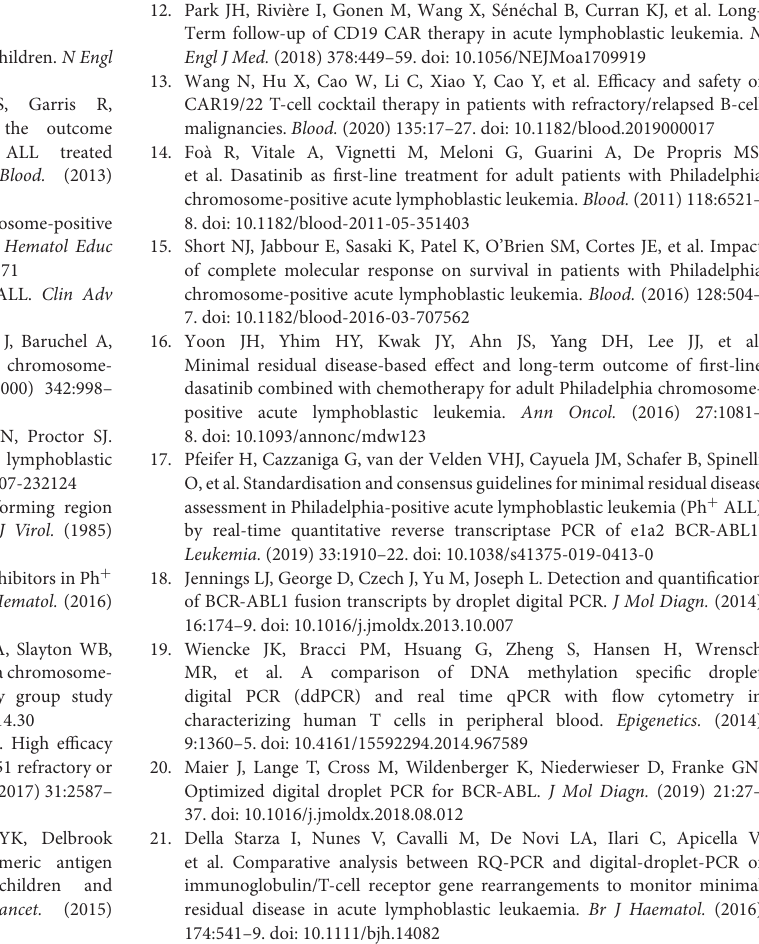
Supplementary Table 2 | Baseline characteristics of all enrolled patients with Ph +